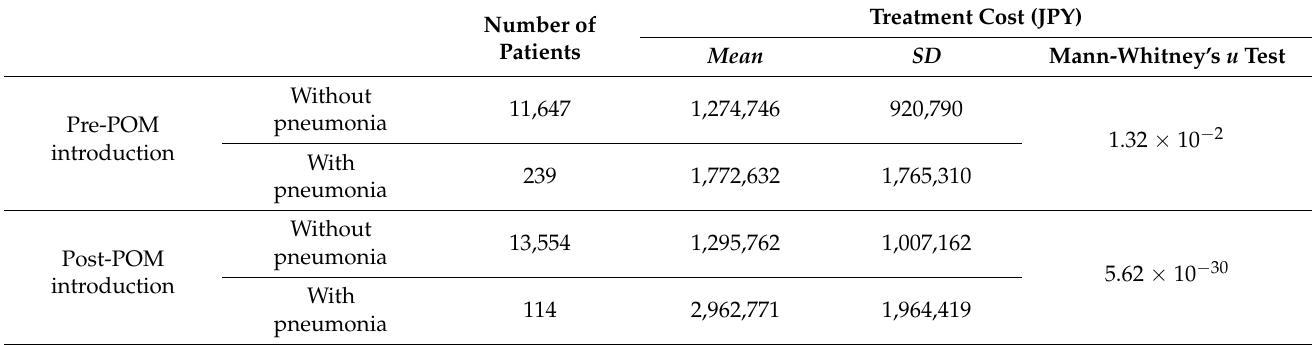
Table 3. Relationship between treatment cost and the presence of postoperative